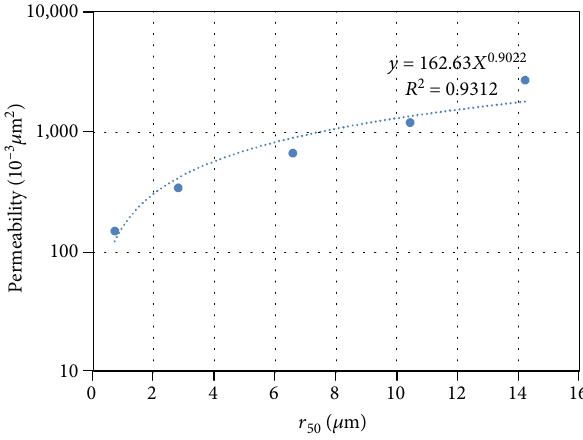
Figure 12: Scatter plot of permeability and r